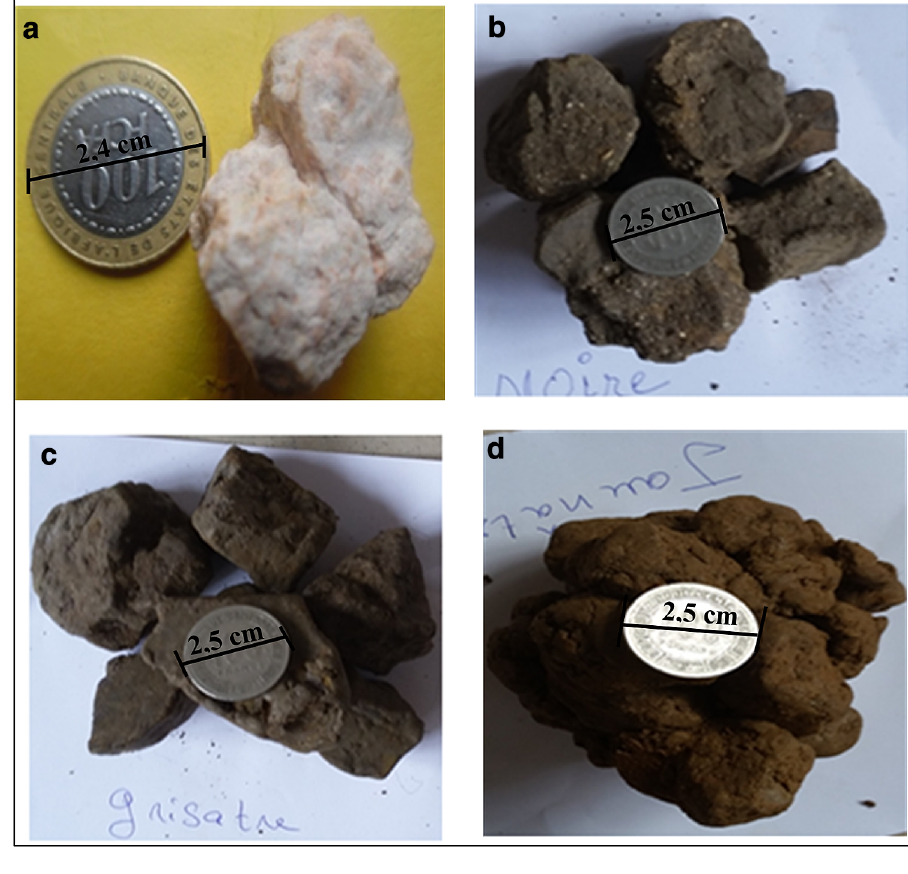
Fig. 1 Raw material showing: a Feldspar crystal, b Black clay, c Gray clay, d yellow clay